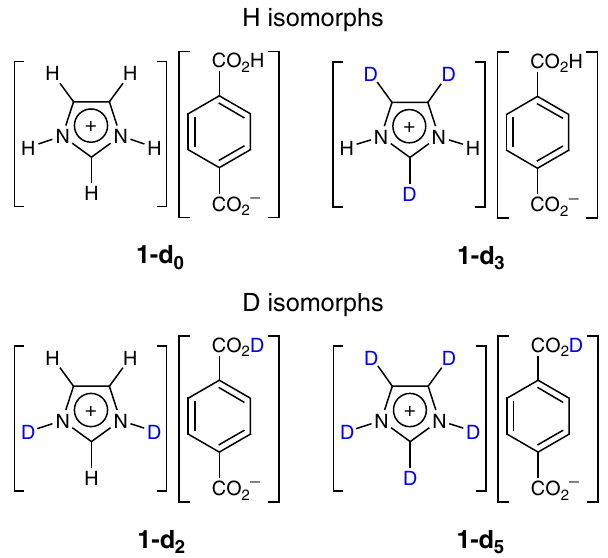
Fig. 1 Chemical structure of 1 . Isotopologs 1-d 0 , 1-d 2 , 1-d 3 , and 1-d 5 (the subscript referring to the number of deuterium atoms in Im) are classi fi ed into H isomorphs and D isomorphs according to the deuteration state of the carboxyl group COOH. Note: Isotopologs refer to a group of compounds differing in the number and/or position of atom substitutions by isotopes, while isomorphs refer to crystals belonging to the same space